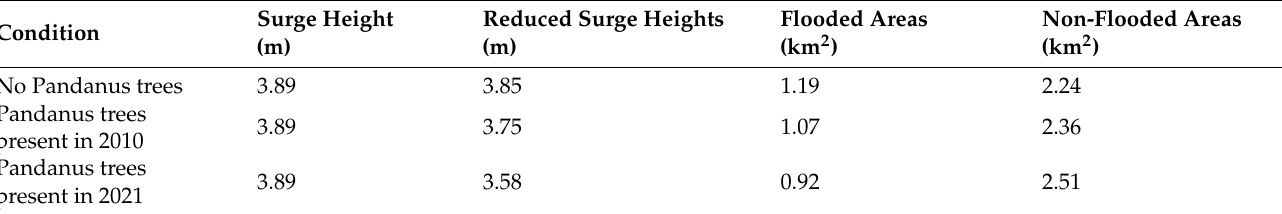
Figure 10. NDWI indices of the study area.